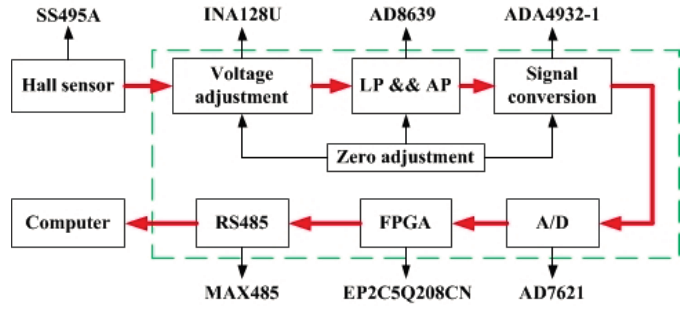
Figure 6. Structure of data acquisition